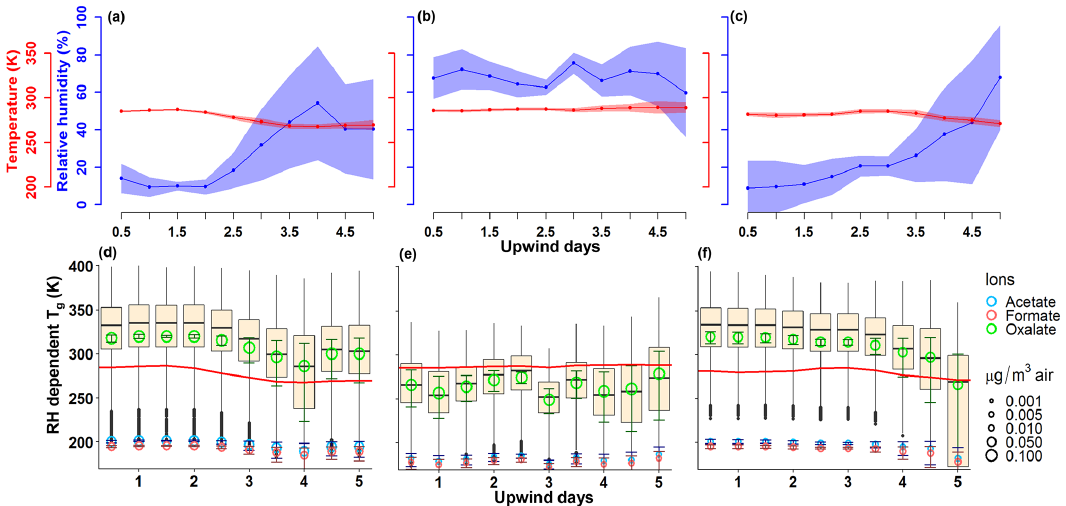
Figure 7. Panels (a) – (c) contain the ambient conditions extracted from the GFS analysis along the FLEXPART modeled path weighted by the residence time for PMO-1, PMO-2, and PMO-3, respectively. The line represents the mean value and the shading represents 1 standard deviation of the values. Panels (d) – (f) contain the box plot distributions of the RH-dependent T g values for molecular formulas using the maximum, mean, and minimum RH for PMO-1, PMO-2, and PMO-3, respectively. The T g values for the full composition of each sample were calculated using the maximum, mean, and minimum RH and then all three sets of data are combined and plotted as a single distribution for each time period. The open circles represent the abundance and Boyer–Kauzmann estimated T g for the acid forms of the three most abundant low-MW organic ions, the bars around the circles represent the range of possible T g values for those compounds when the range of RH is considered. The red line demonstrates the ambient temperature at each time point, as extracted from GFS. The centerline of the box plot represents the median, and the top and bottom of the box represent the third and first quartiles, respectively. The whiskers represent Q3 + 1.5 ∗ interquartile range (IQR, Q3–Q1, maximum), and Q1 − 1.5 ∗ (IQR,